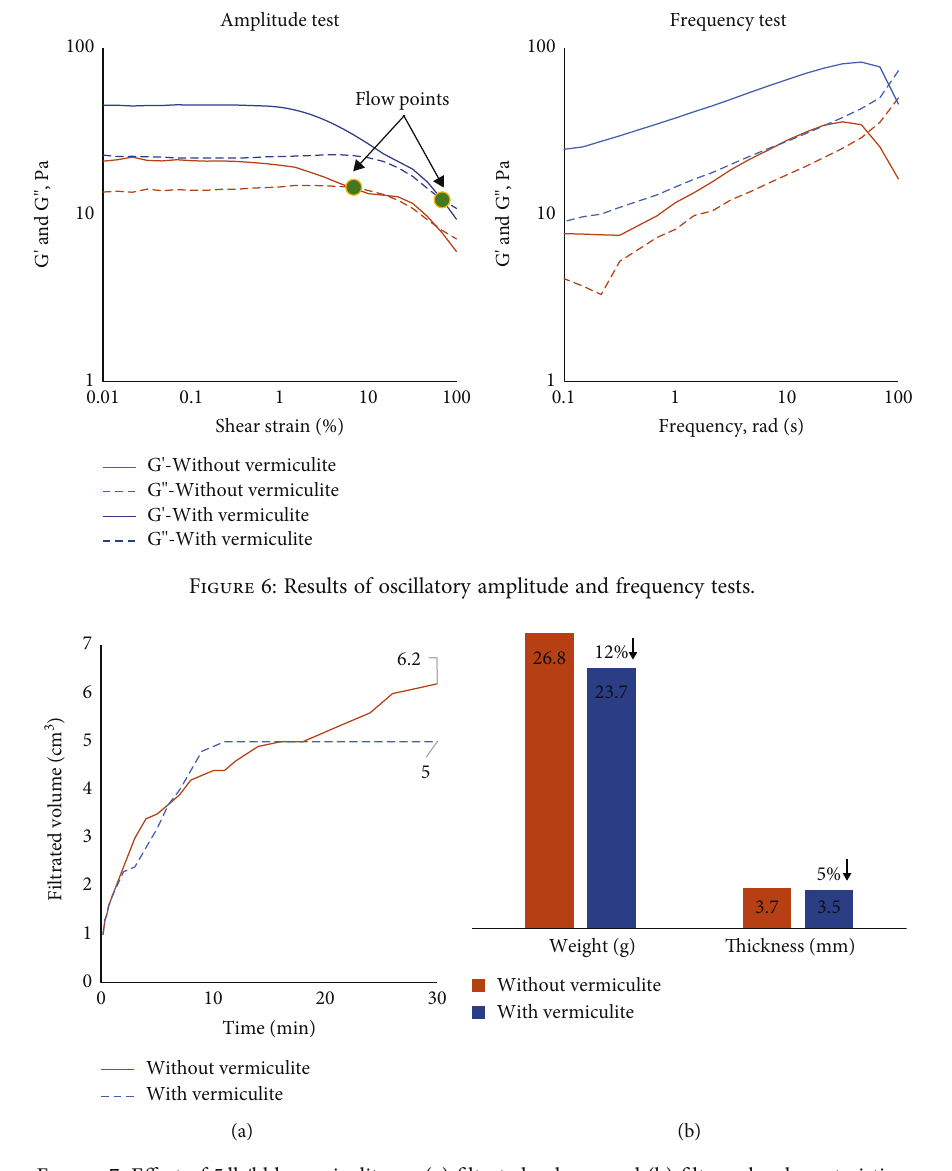
Figure 7: E ff ect of 5 lb/bbl vermiculite on (a) fi ltrated volume and (b) fi lter cake